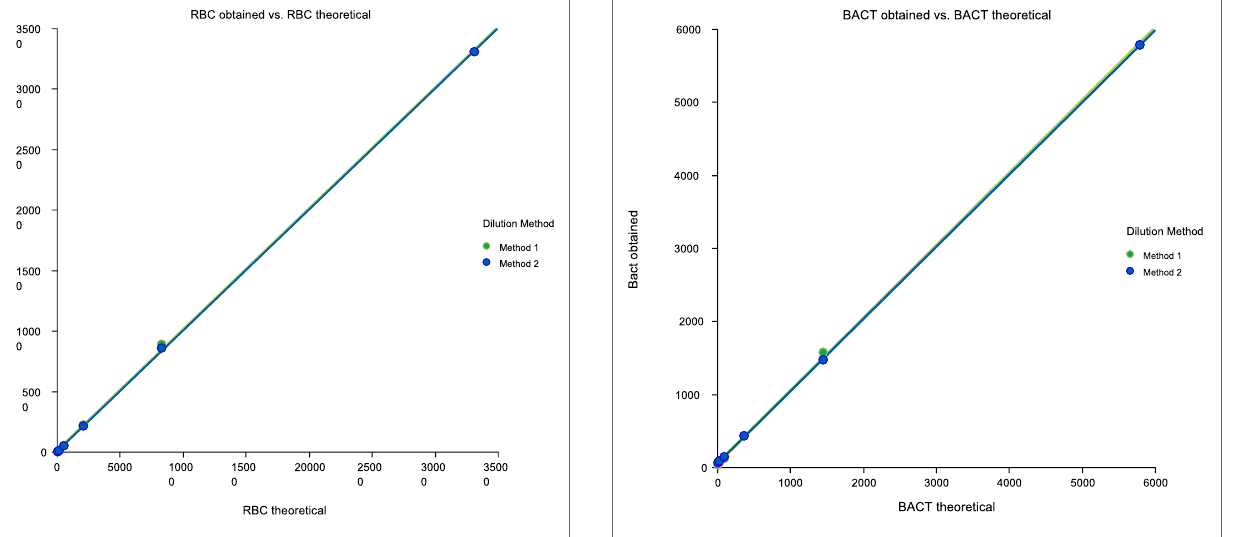
FIgURe 7 | Scatter diagram of obtained and theoretical bacteria in sample